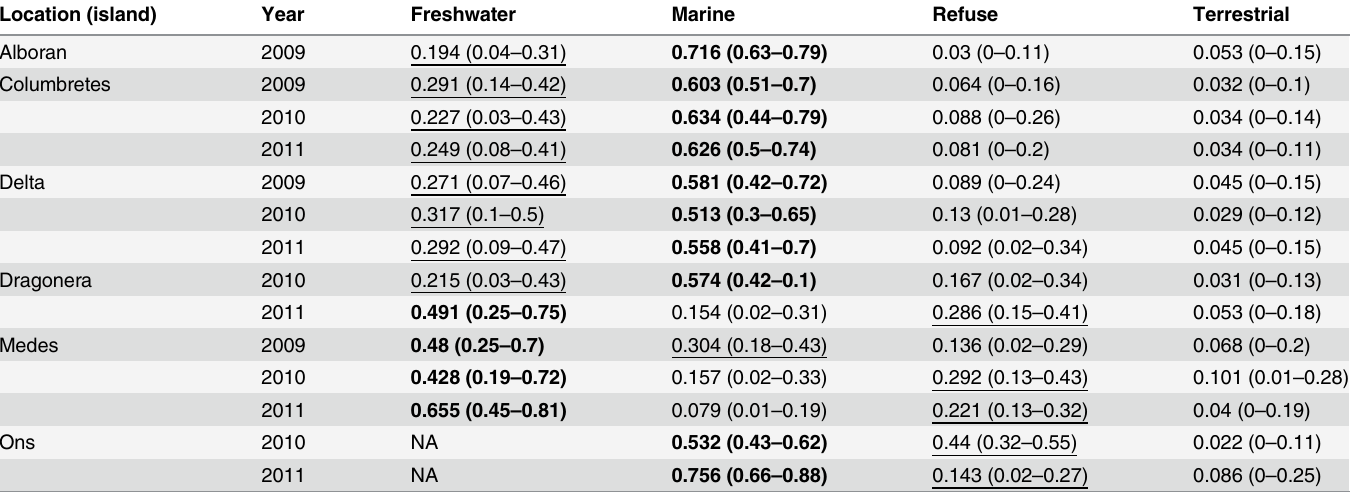
Table 3. Diet reconstruction with Bayesian mixing model: percentage of use of main food sources for each breeding colony and year. Given values are medians, with 95% credibility intervals in brackets. Values in bold represent the main food source; underlined values represent the secondary source. Location